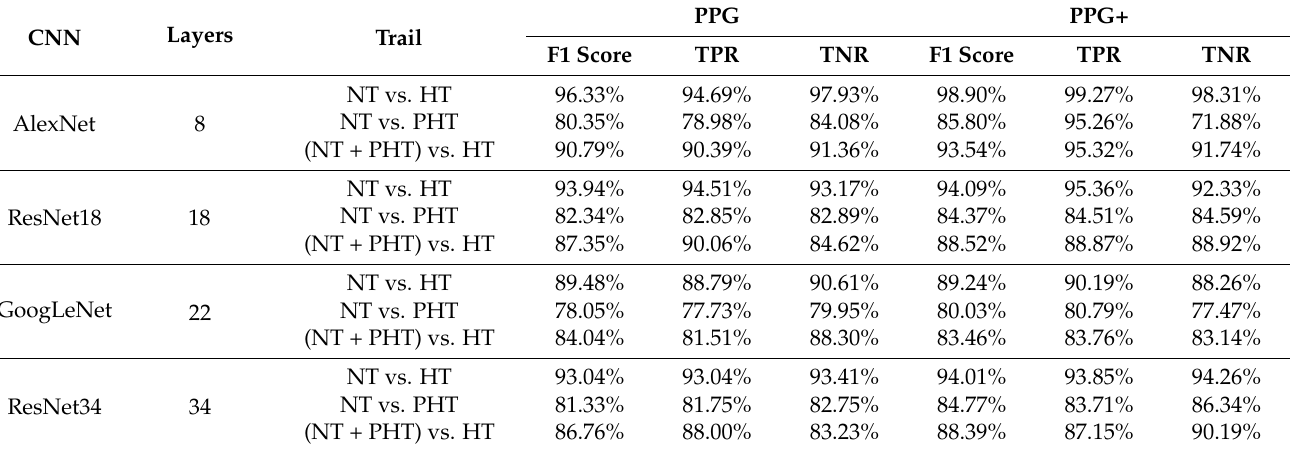
Table 2. Classification performance of the proposed deep learning method. TPR stands for true positive rate and refers to the sensitivity of the model. TNR is short for true negative rate and refers to the specificity of the model. PPG PPG+ CNN Layers Trail F1 Score TPR TNR F1 Score TPR TNR NT vs. HT AlexNet